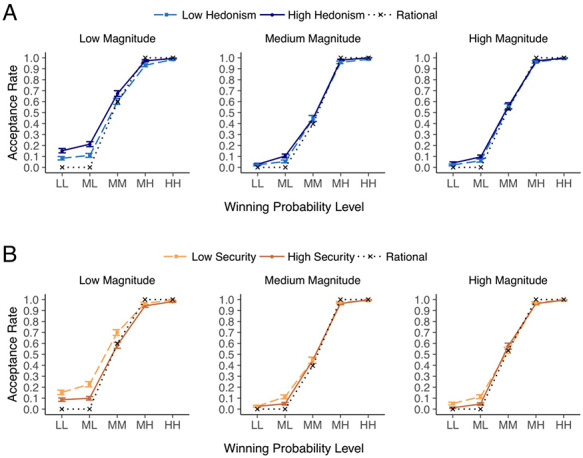
Associations between (A) hedonism and (B) security and acceptance rates (ARs) in the Lottery Choice Task (LCT). Participants’ mean ARs are shown over three magnitude levels and five winning probability levels based on a median split of the respective personal value ratings (see Supplementary Figure S1). LL = low-low; ML = middle-low; MM = middle-middle; MH = middle-high; HH = high-high. Error bars represent ±1 SE. The dotted line marks the trend of a hypothetical rational decision-maker who solely relies on the expected value (EV) of lottery trials (accept if EV > 0 and reject if EV < 0). Missed decisions [mean (s.d.) = 2.37 (3.34) per person] were not included in the figure. See Supplementary Figure S4 for modeled ARs based on coefficients estimated using Equation 1.